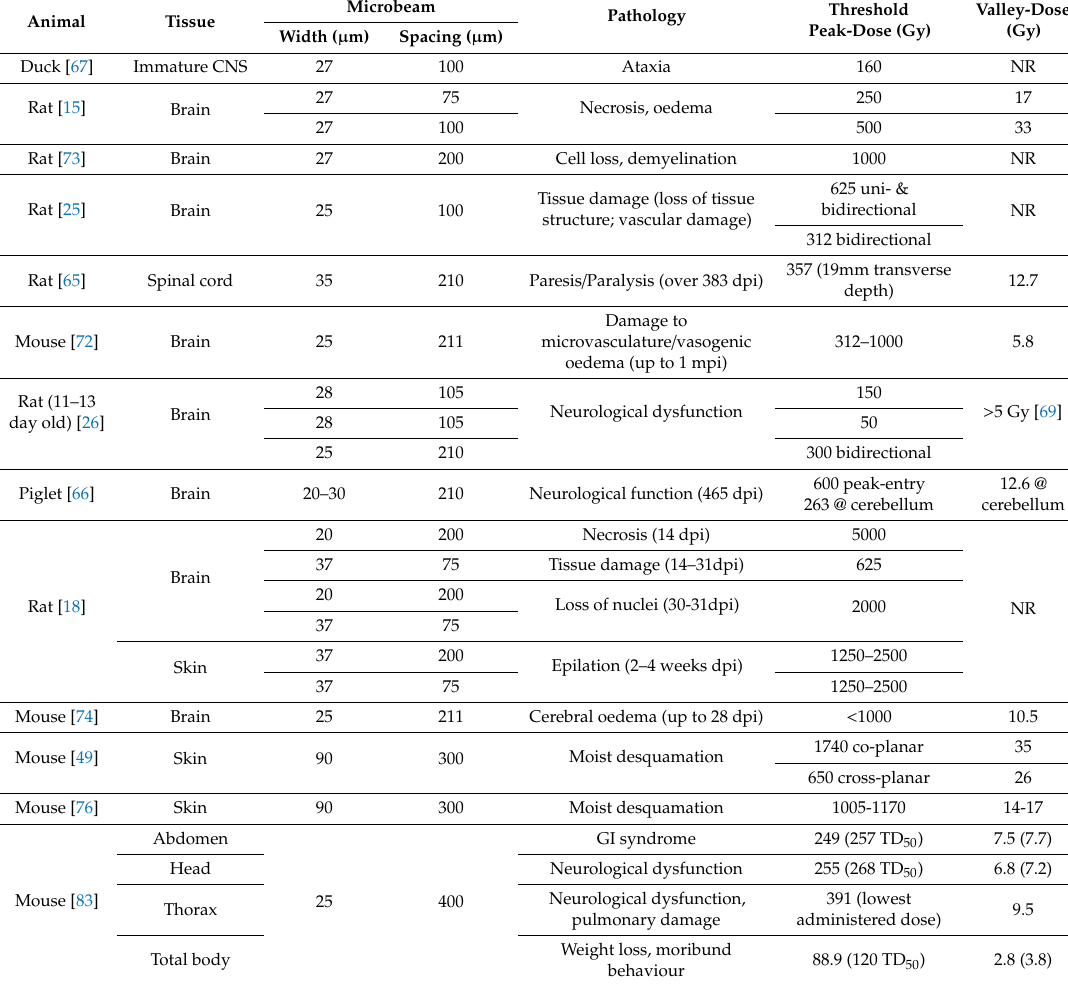
Table 2. MRT Parameters Eliciting Normal Tissue